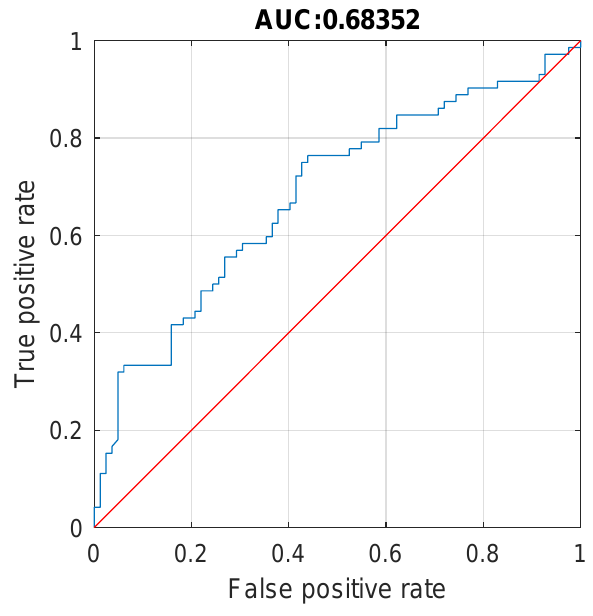
Figure 15. Receiver operating characteristic (ROC) for SPCR differentiating patients with essential tremor (A2) and cervical dystonia with head tremor (B2). Area under curve (AUC) is 0.68352 (95% confidence interval